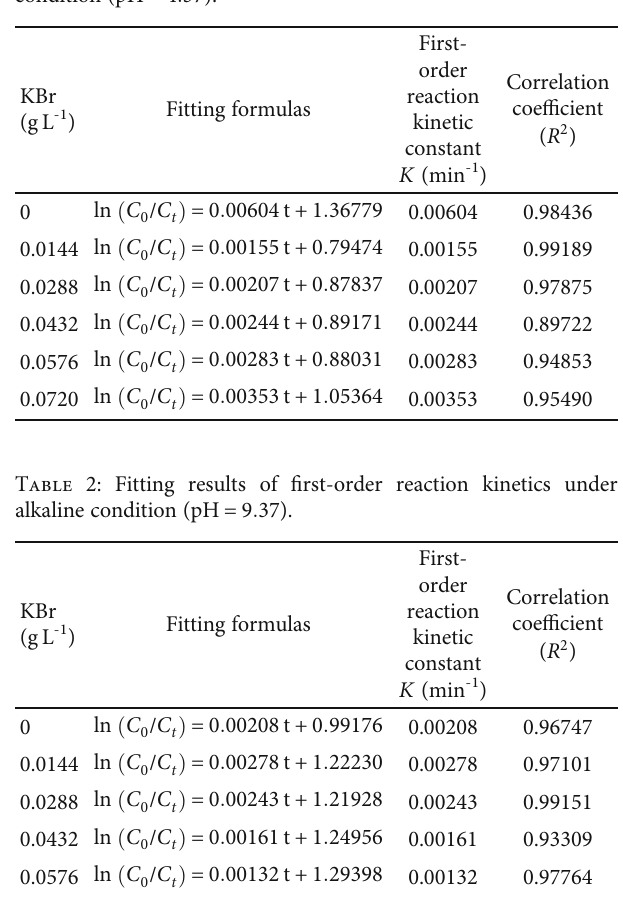
Table 1: Fitting results of fi rst-order reaction kinetics under acidic condition ( pH = 4 : 37 ).